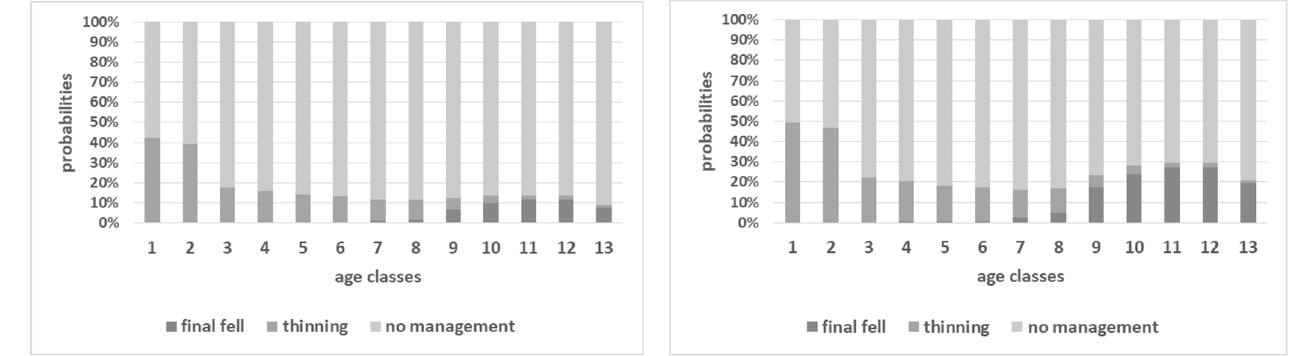
Figure 6. Activity probabilities according to the age classes—state forest (on the right ) and other forest ownership types (on the left ).